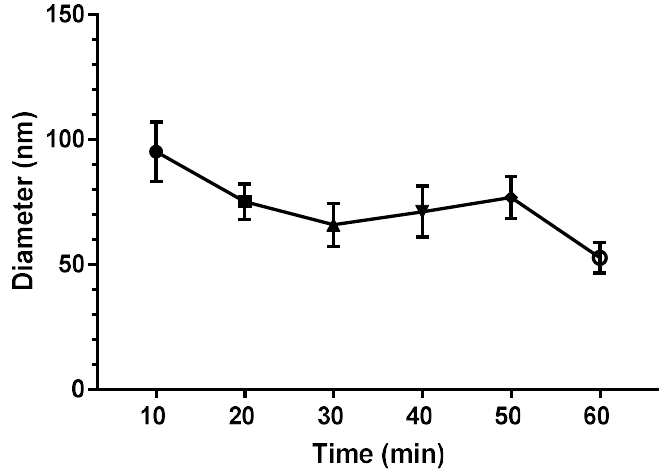
Figure 4. Inner diameter of the TNTs as a function of the anodizing time.